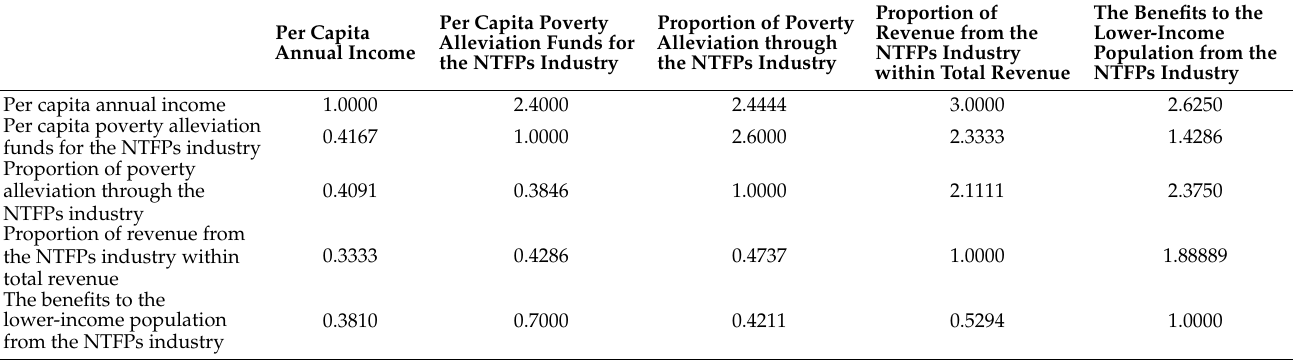
Table A5. C1–D: Judgement matrix of the economic